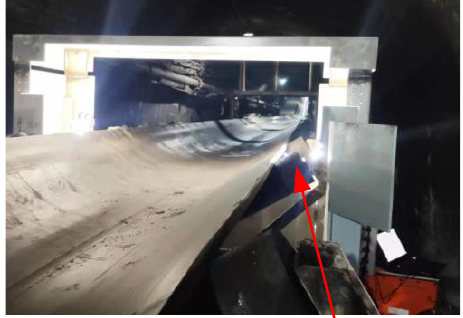
Figure 15. Application of the proposed research. ( a ) A mine site. ( b ) The installed device.